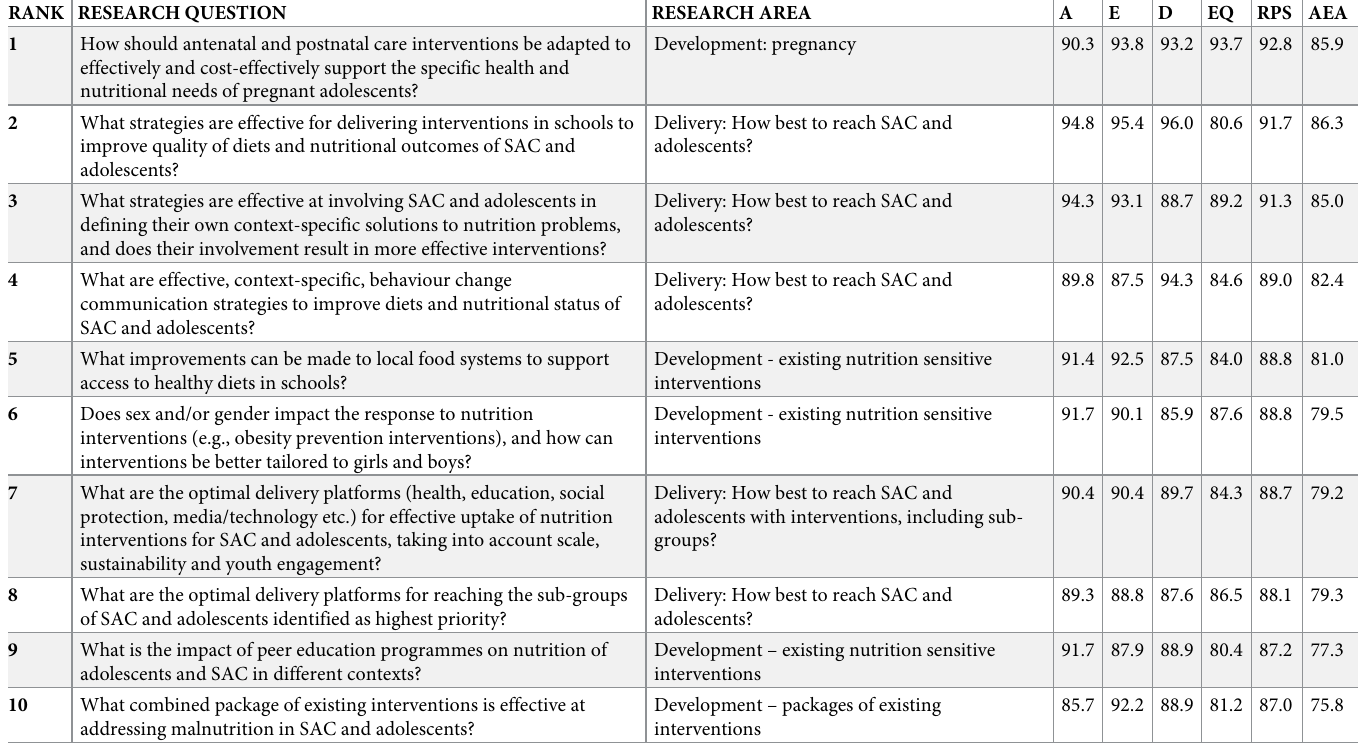
Table 2. Overall top ten ranked research questions across all